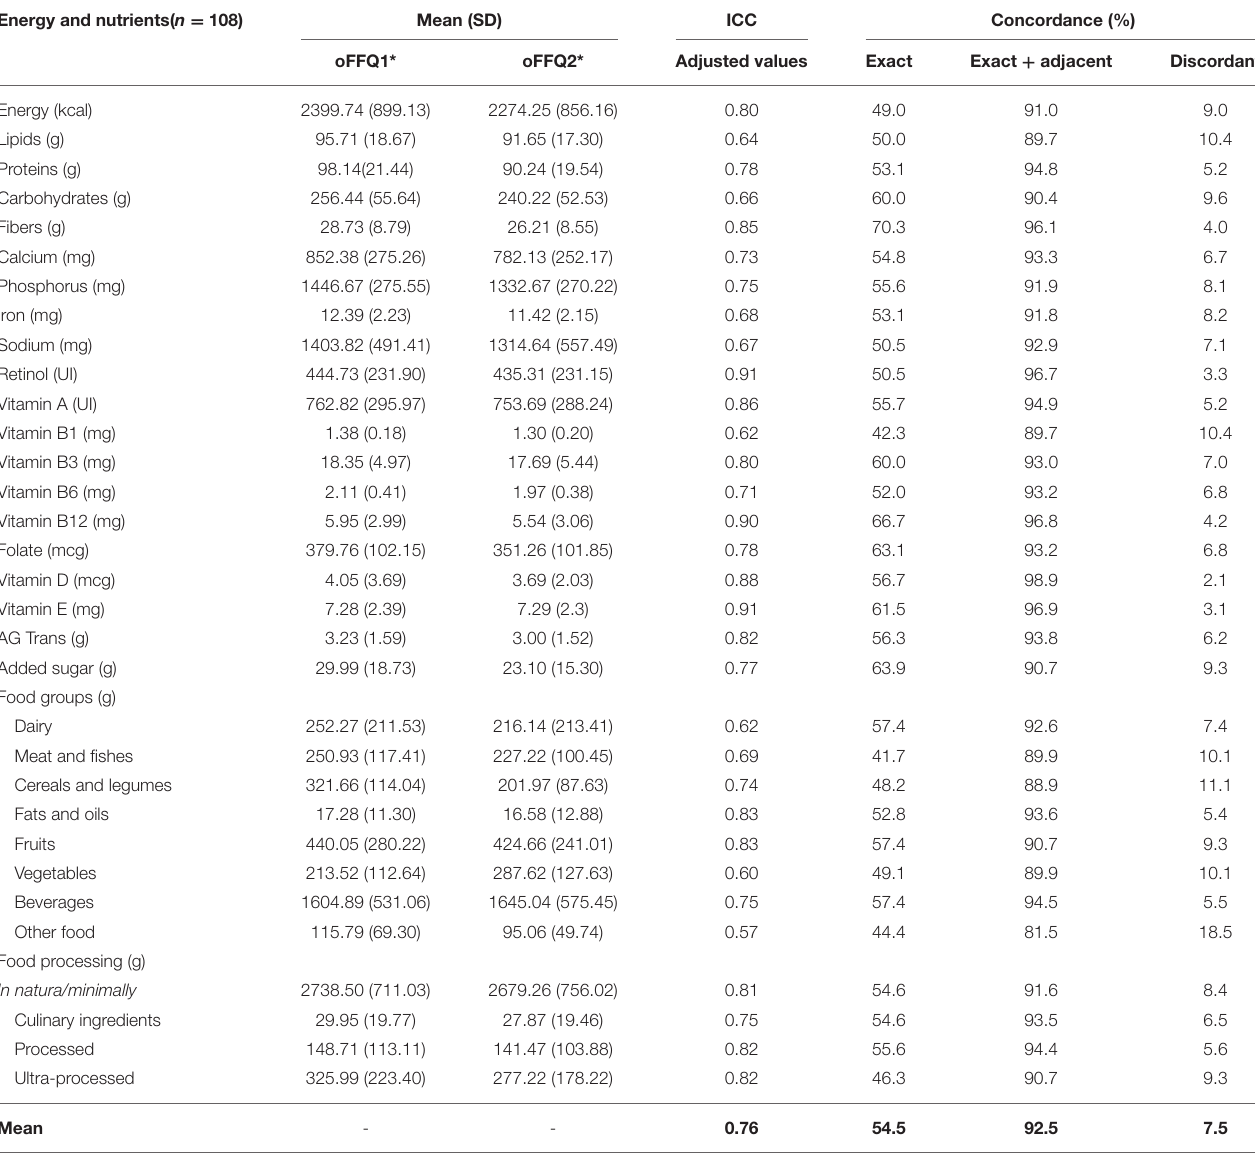
TABLE 3 | Mean and SD of daily consumption, intraclass correlation coefficient (ICC), and percentage (%) of concordance between the online food frequency questionnaire 1 (oFFQ1) and the online food questionnaire 2 (oFFQ2) ( n = 108 participants). Energy and nutrients( n =